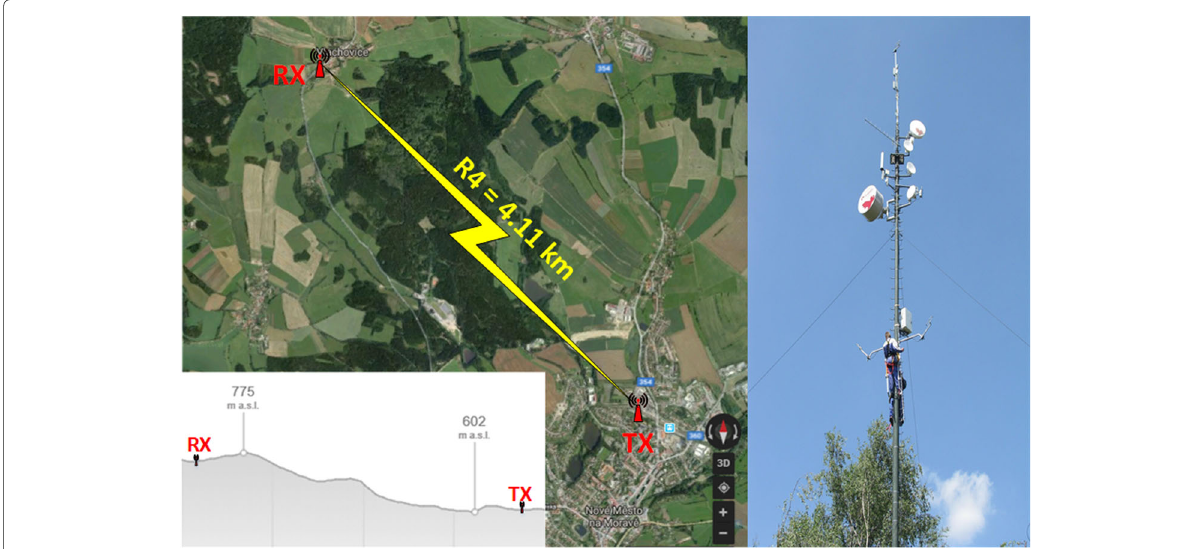
Fig. 2 Measurement location for R4 route. Non-line of sight R4 = 4.11km route and the position of the receiver antenna on the middle of the mast. Map source: Google.com,